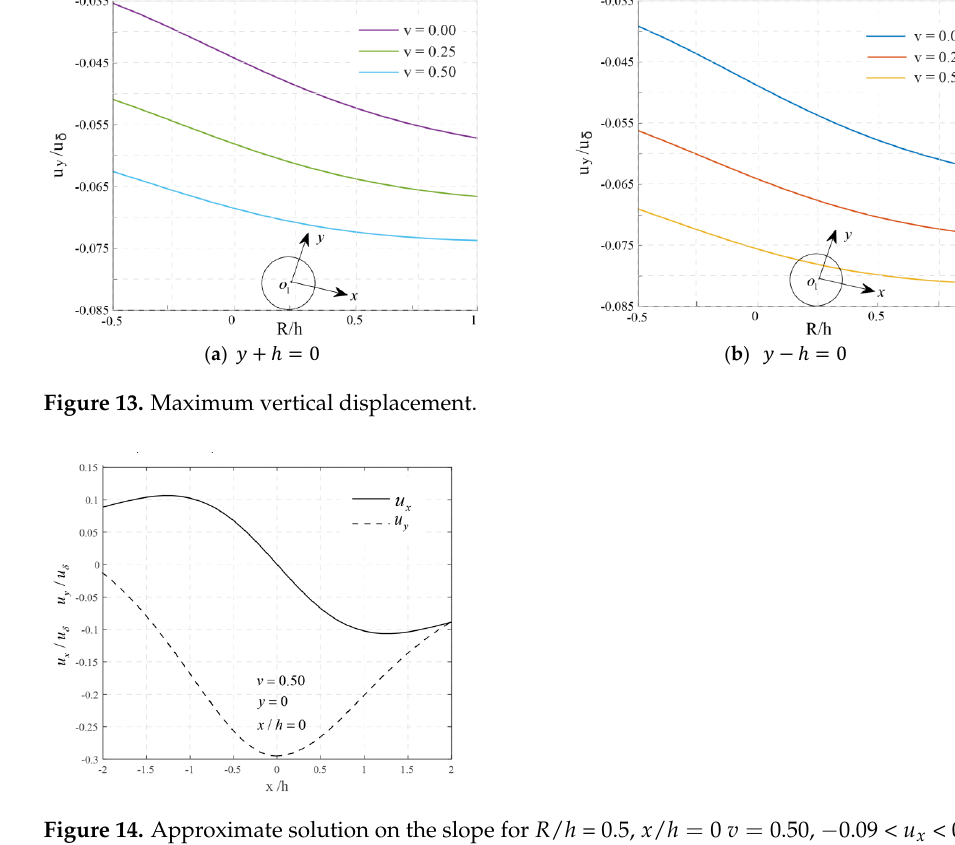
Figure 15. Relationship between the approximate solution on the slope and the exact solution.